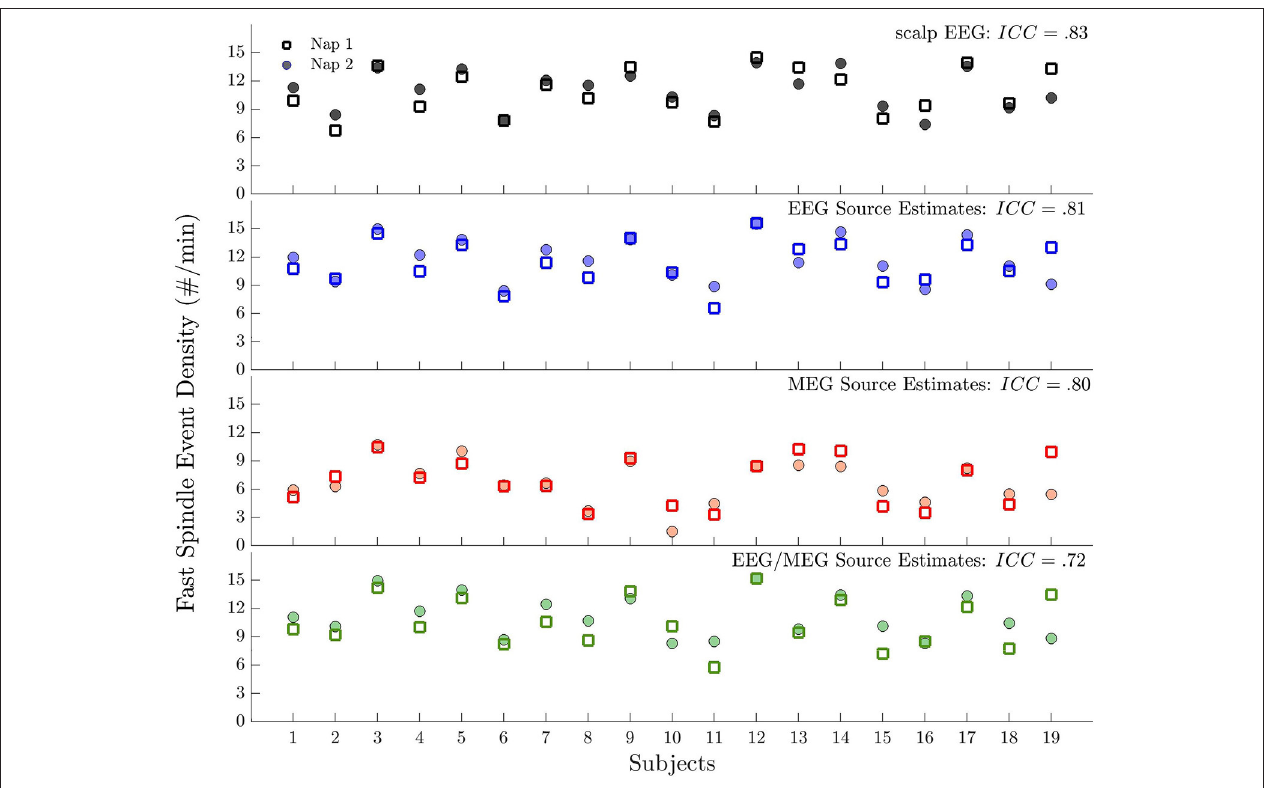
FIGURE 5 | Test-retest reliability of spindle events across naps for each modality. Plot of spindle event density for each subject during Nap 1 and Nap 2. Spindle events were detected (from top to bottom) at scalp EEG, source EEG, MEG, and EEG/MEG.